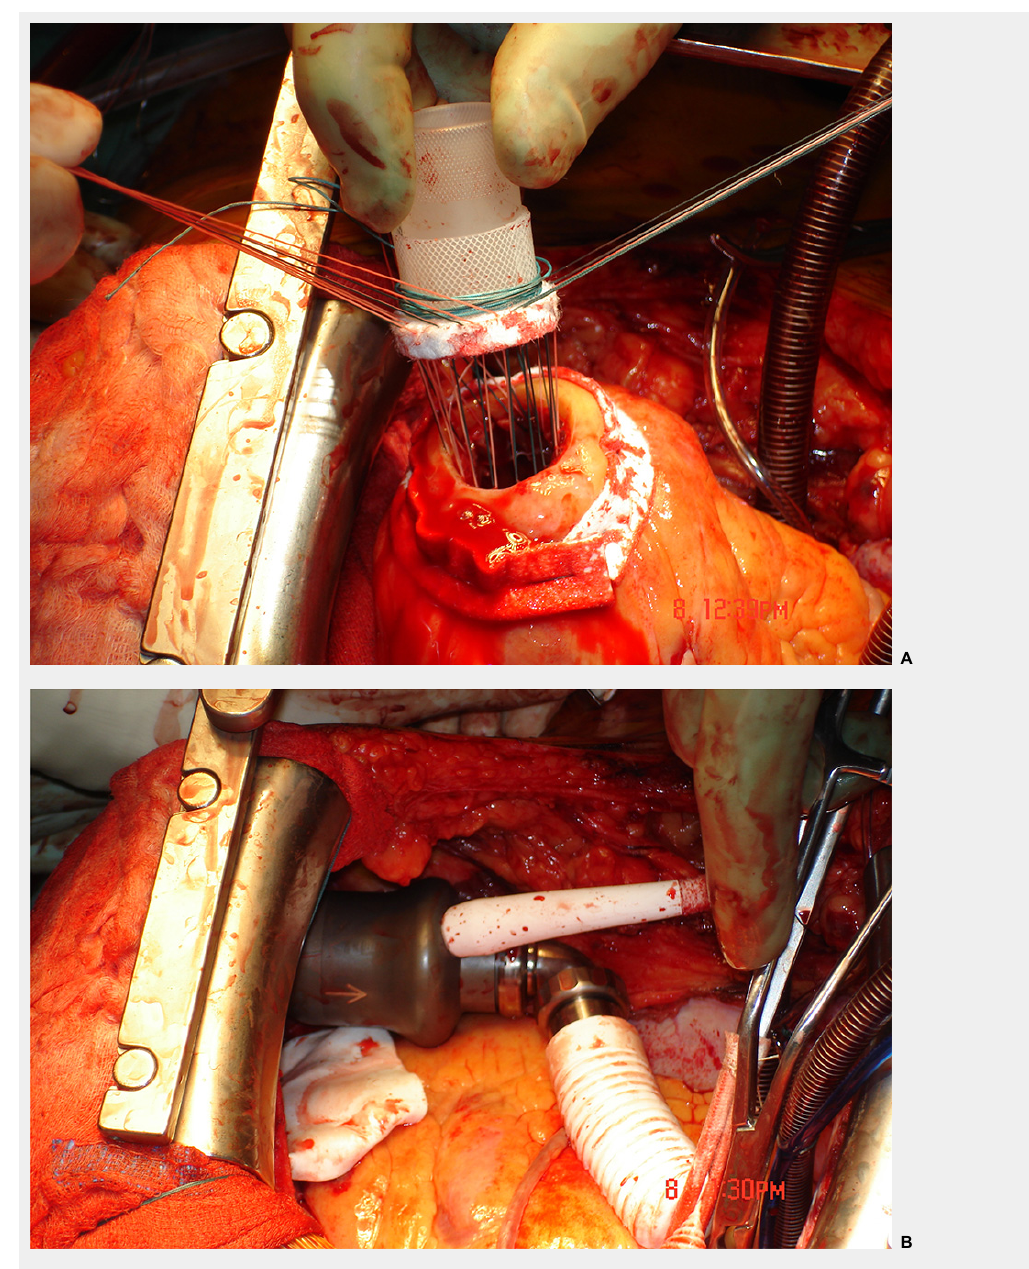
A: Fixation of the sewing ring for further insertion of the device wihtin the left ventricular apex. B: Device in situ